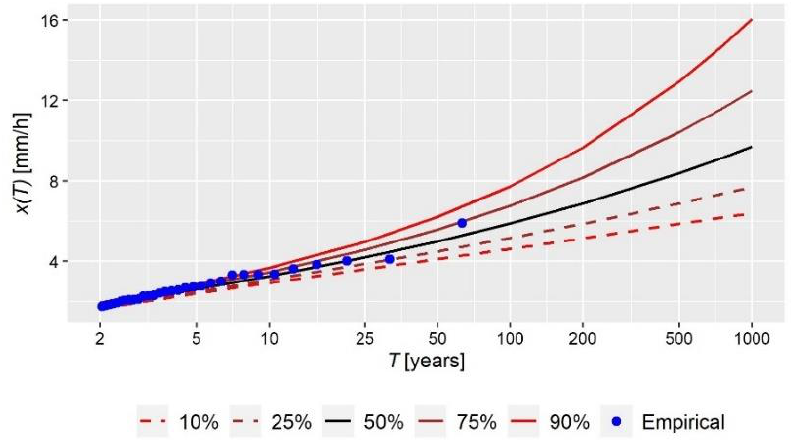
Figure 3. Maximum daily (24 h) rainfall intensity, x ( T ) (mm/h) vs. return period T (years) (including confidence levels).